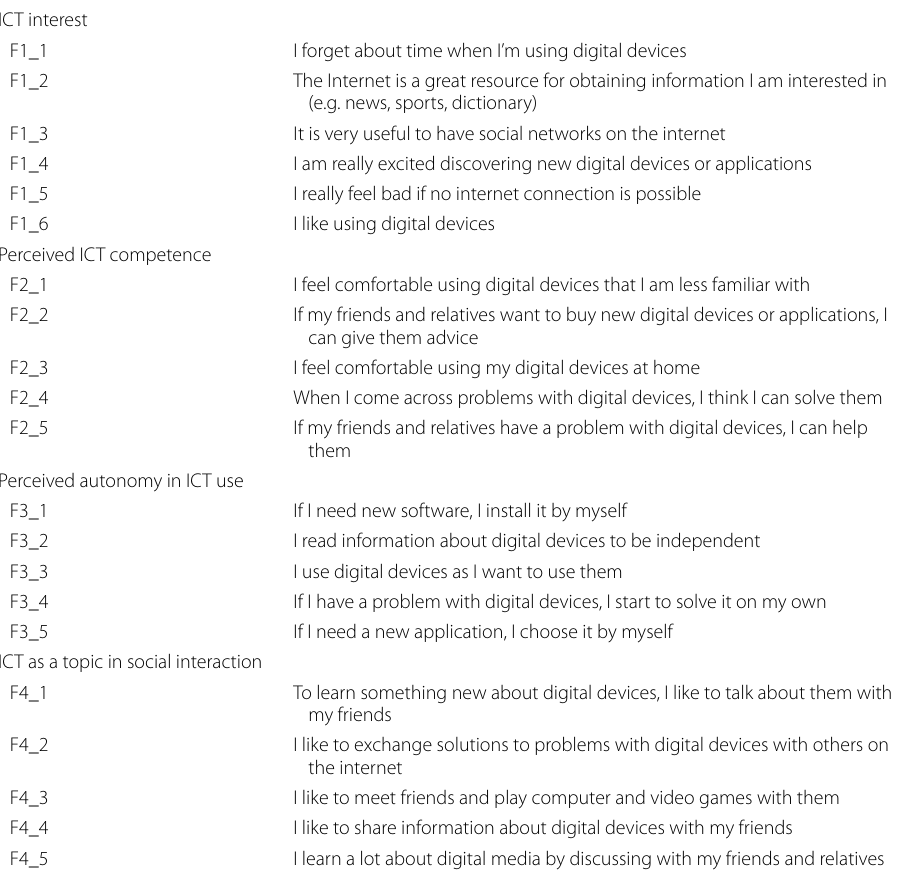
Table 1 Items for the assessment of ICT Engagement ICT